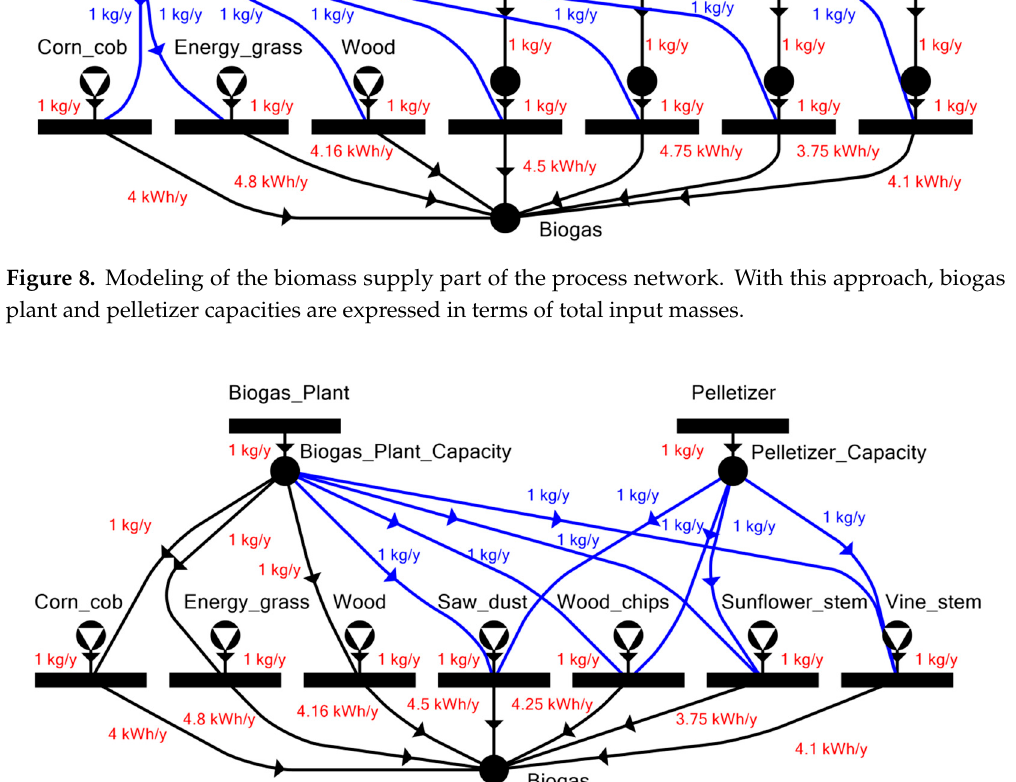
Figure 8. Modeling of the biomass supply part of the process network. With this approach, biogas plant and pelletizer capacities are expressed in terms of total input masses.